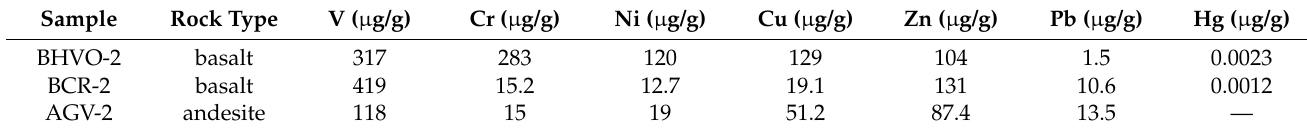
Table 1. The trace element data of the reference materials analyzed in this study.